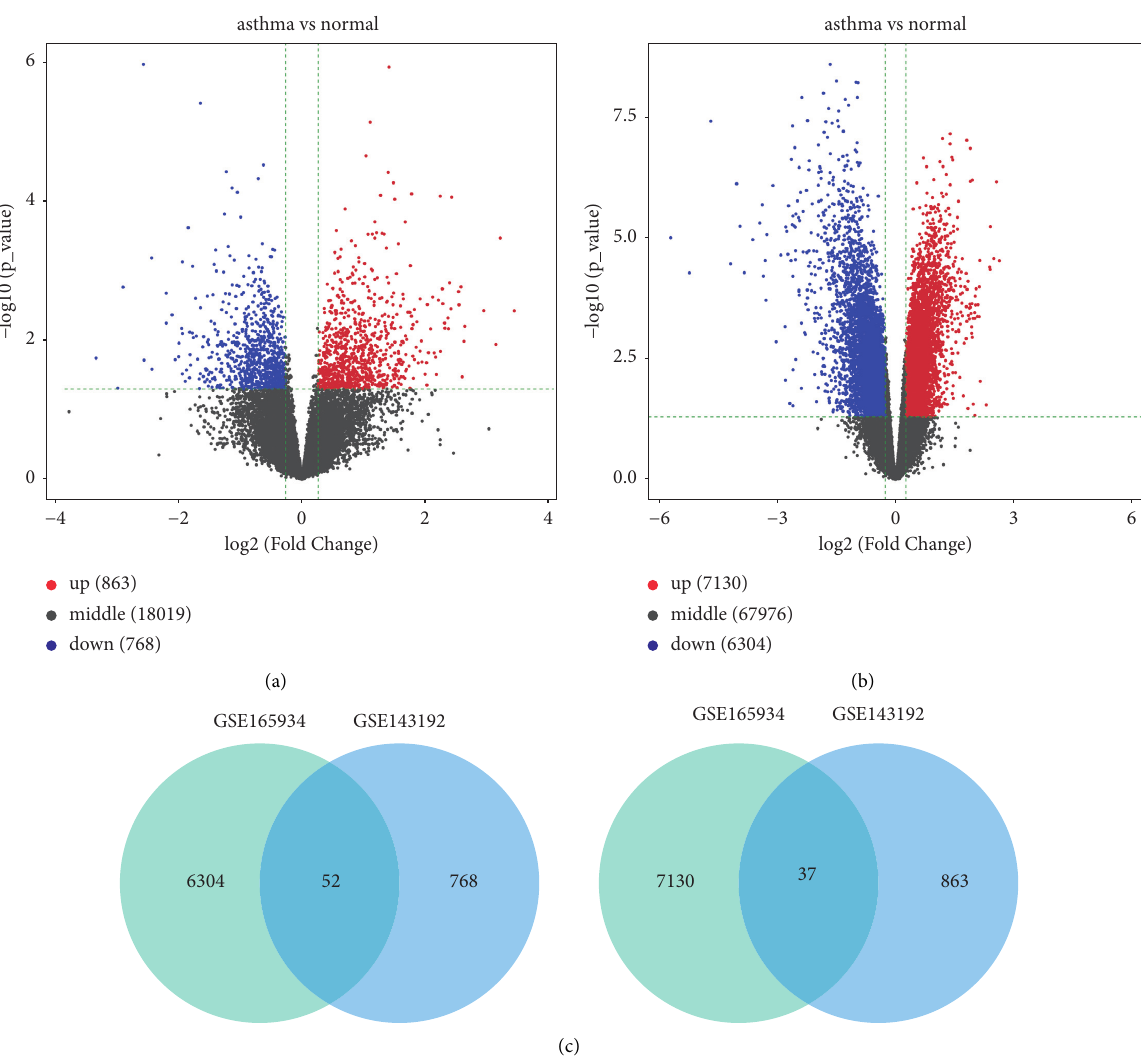
Figure 1: Identification of DElncRNAs in PBMCs between asthma and normal children. (a) The volcano plot showing a total of 1631 DElncRNAs in PBMCs between asthma and normal children after differential expression analysis on the GSE143192 dataset. (b) The volcano plot showing a total of 13434 differentially expressed genes in PBMCs between asthma and normal children after differential expression analysis on the GSE165934 dataset. (c) Venn plots showing overlapping 52 downregulated DElncRNAs and 37 upregulated DElncRNAs in PBMCs between asthma and normal children by analyzing the GSE143192 and GSE165934